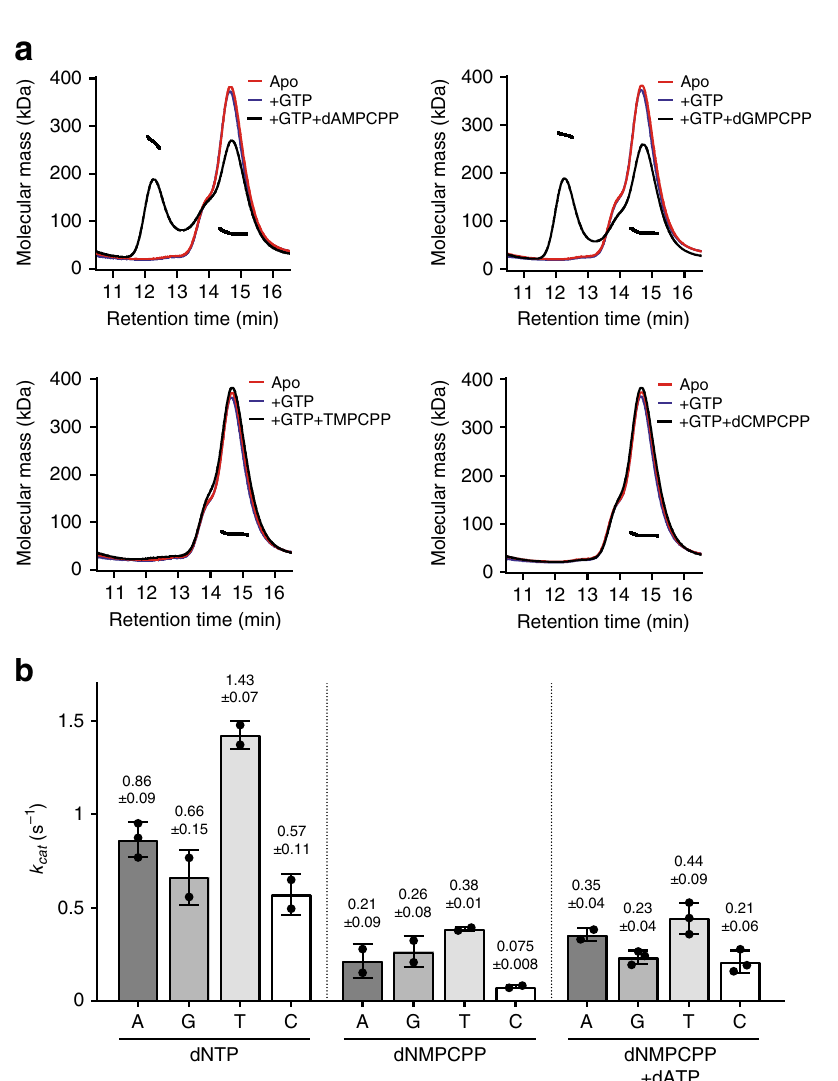
Fig. 2 SAMHD1 tetramerisation and hydrolysis of dNMPCPP analogues. a SEC-MALLS analysis of SAMHD1 monomer – dimer – tetramer equilibrium upon addition of dNMPCPP nucleotides. In each panel, the solid lines are the chromatograms from the output of the differential refractometer and the black scatter points are the weight-averaged molar masses determined at 1-s intervals throughout elution of chromatographic peaks. In each panel, the displayed curves are: (red) apo-SAMHD1; (blue) SAMHD1 and 0.2 mM GTP; and (black) SAMHD1, 0.2 mM GTP and 0.5 mM indicated dNMPCPP analogue. b Bar chart of the apparent k cat values derived from 1 H NMR data recorded for GTP-stimulated SAMHD1 hydrolysis of each dNTP, dNMPCPP and dNMPCPP/ dATP reaction, see Supplementary Fig. 3. Points overlaid in each bar are the individual data measurements, the error bars represent the standard deviation (s.d.) from at least two independent measurements. The source data are provided in the Source Data fi